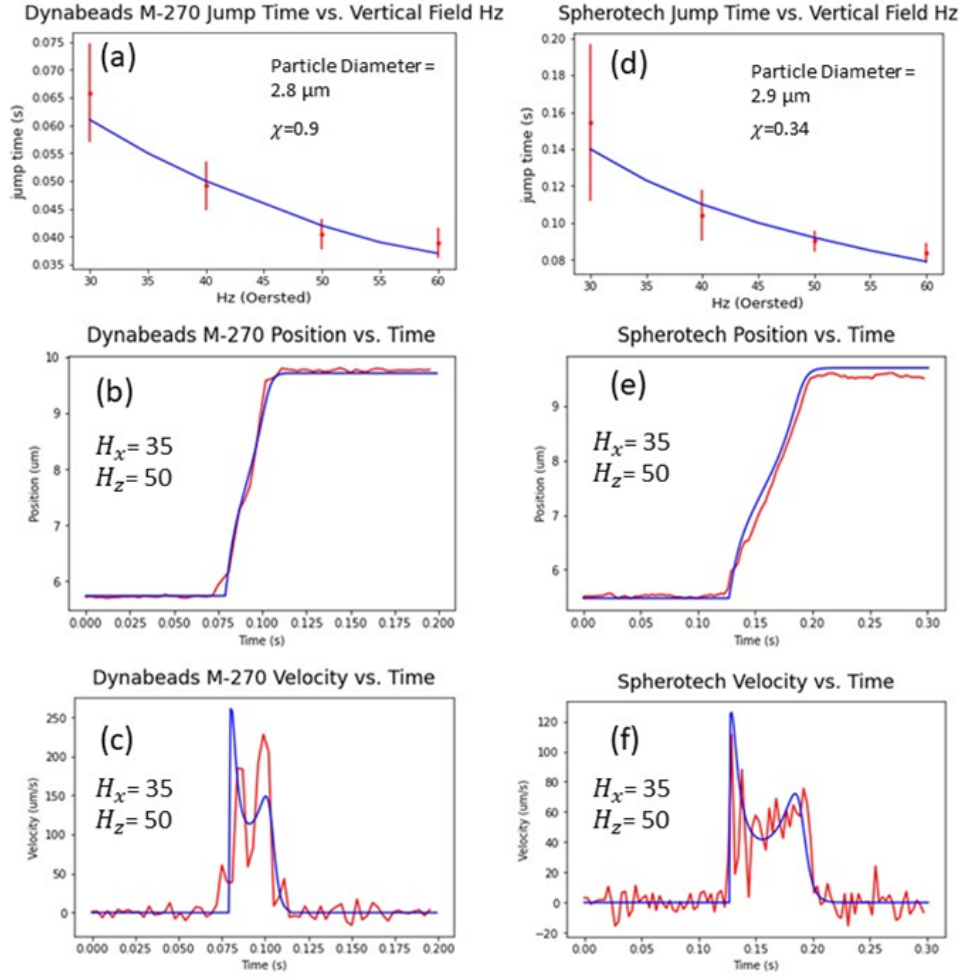
Figure 4. Short-range hopping. ( a , d ) Jump time decreases with (cid:1834) (cid:3053) . Error bars calculated from the standard deviation of jump times for 10 s of jumps. ( b , c , e , f ) Position and velocity vs. time for disk-to-disk jumps. Blue curves are from the simulation; orange/red from the experiment. Particles are Dynabeads M-270 and Spherotech PMS-20-10.